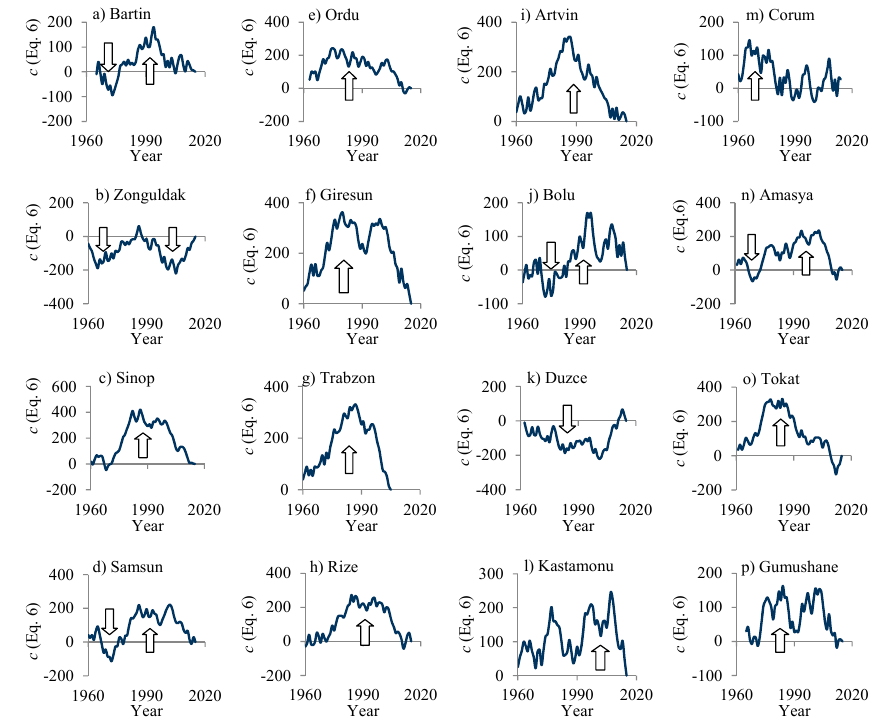
Figure 3. CSD-plot for annual rainfall at stations ( a – p ) selected across the study area. Water 2020 , 12 , x FOR PEER REVIEW